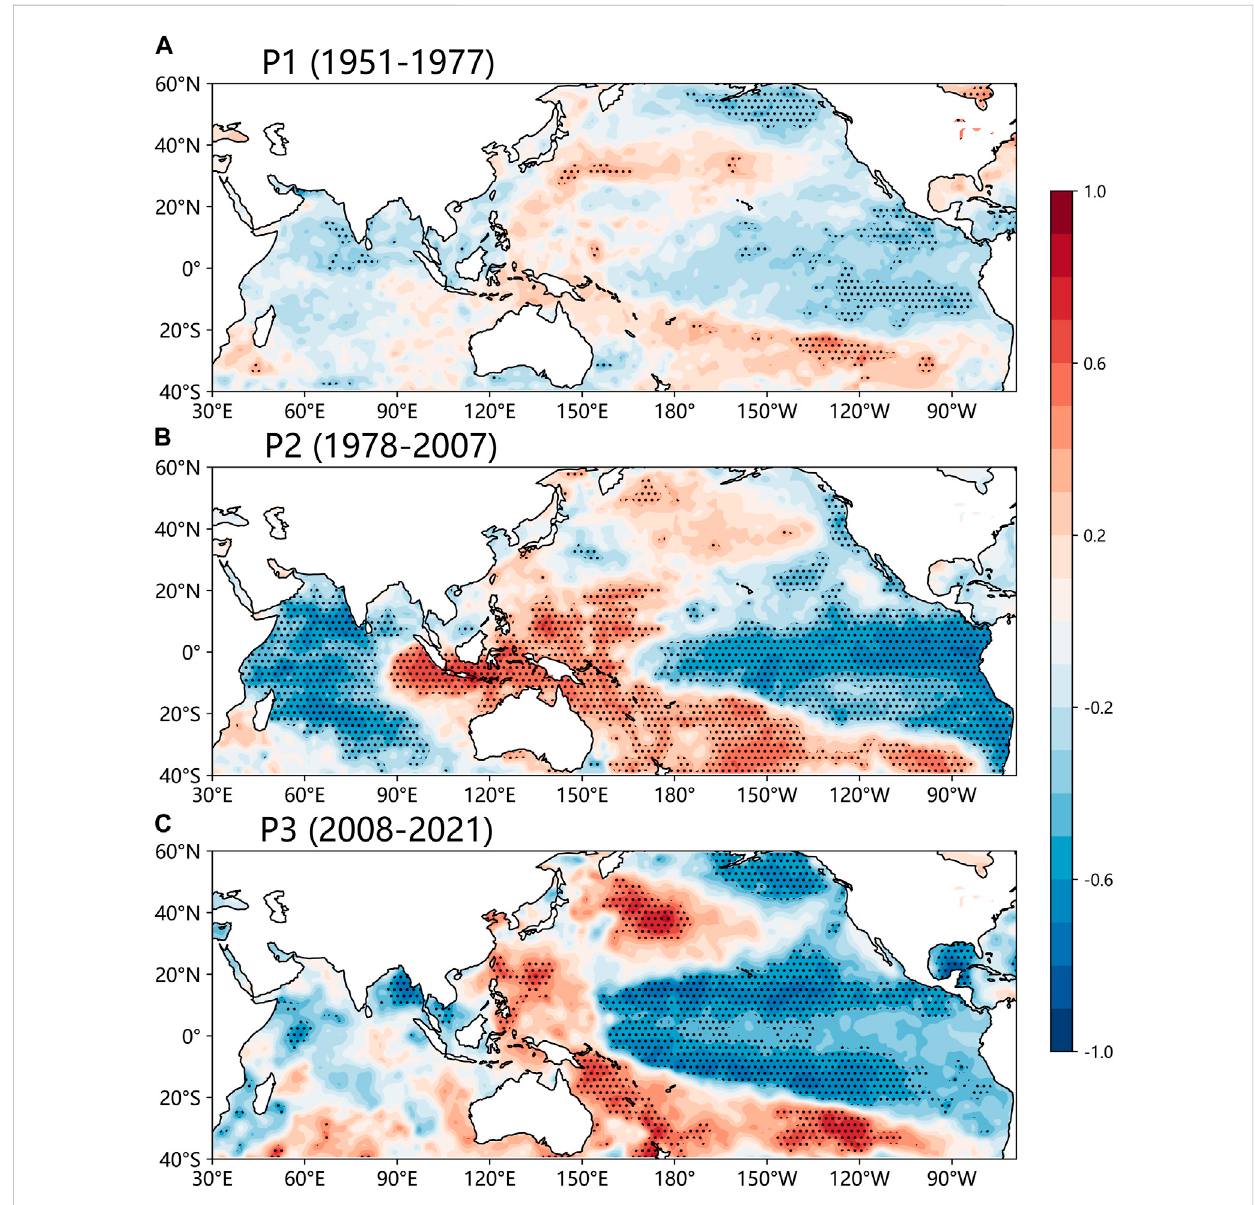
FIGURE 5 Spatialdistributionofthecorrelationcoef fi cientsbetweenSCSSMindexandSSTAinthepreviousautumnduring (A) P1, (B) P2,and (C) P3.Thedotted area indicates that it can pass the 90% signi fi cance